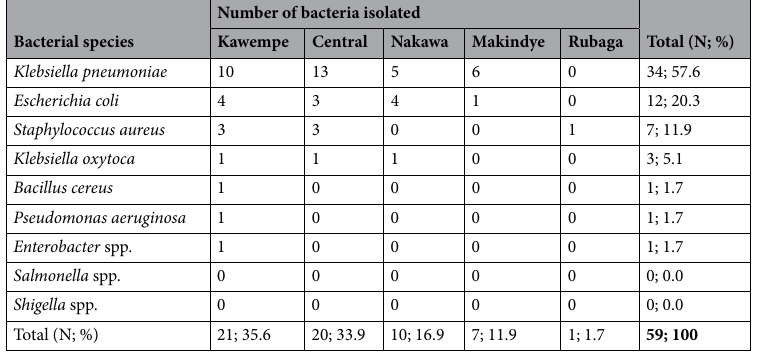
Table 6. Bacterial strains isolated from herbal medicines sold in five divisions of Kampala city (n =